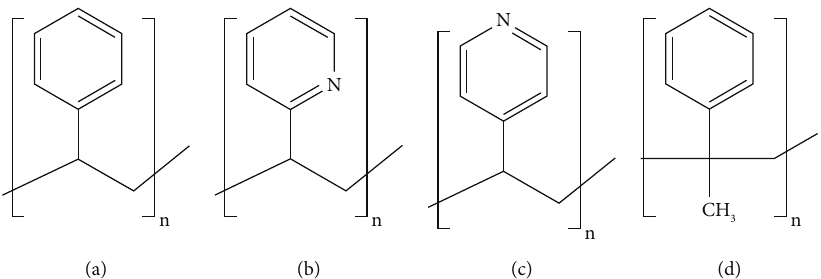
Figure 1: Molecular structure of polystyrene, poly(2-vinylpyridine), poly(4-vinylpyridine), and poly( α -methyl styrene). Table 1: Number and weight average of the molecular weight ( M study.